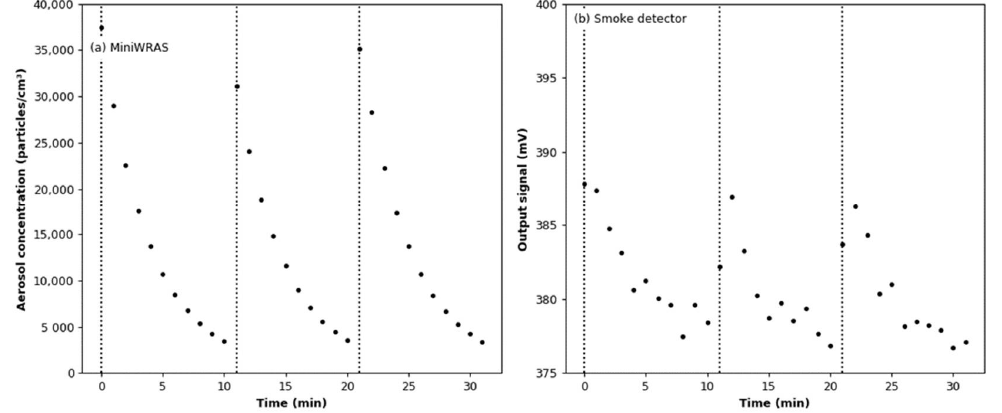
9 of 15 Figure 11. Test aerosol size distribution during the soot effect test. The comparison of the readings from the reference device and the smoke detector is shown in Figure 12. For the output signal from the smoke detector, the effect of adding argon was subtracted for each dose of aerosol. It can be seen that the aerosol particle num- ber concentration drops from the initial value of about 35,000 particles/cm 3 to a level below the lower limit of detection for MiniWRAS in about 10 min after each dose. This is because